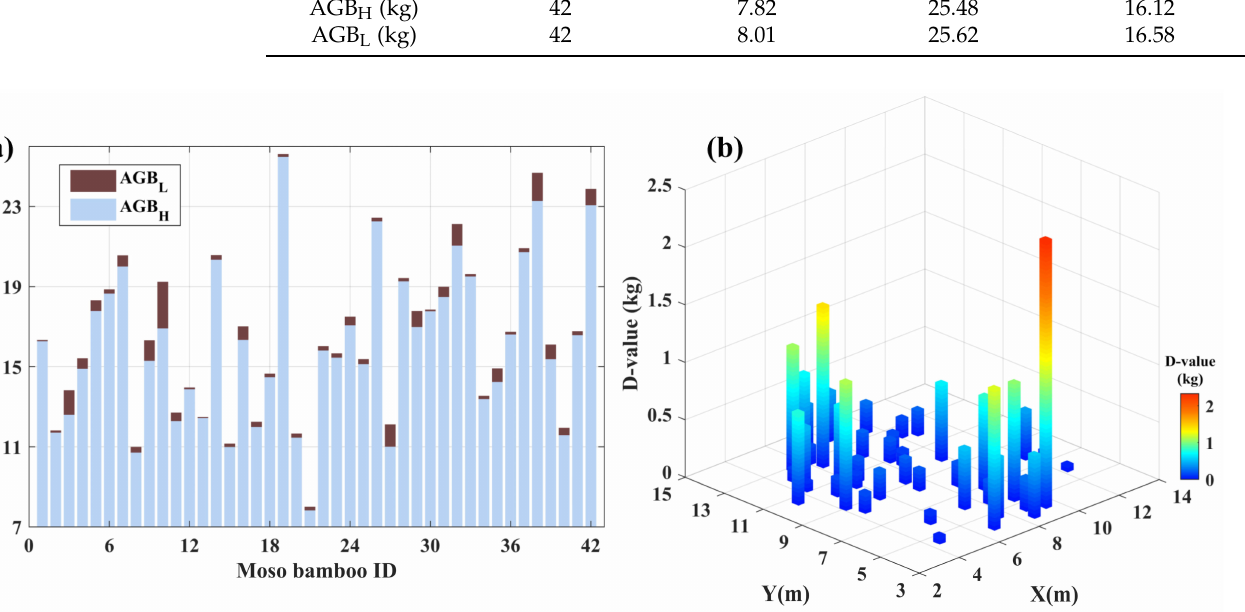
Figure 10. ( a ) AGB H s and AGB L s of individual Moso bamboos; ( b ) Differences between individual AGB H s and AGB L